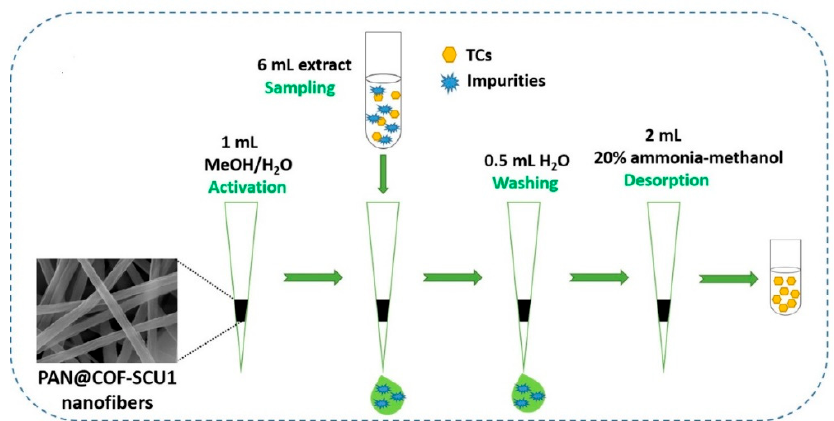
Figure 18. Pipette tip-SPE procedure for the extraction of tetracycline antibiotics (TCs) (adapted with permission from reference [105], copyright 2020, Elsevier).